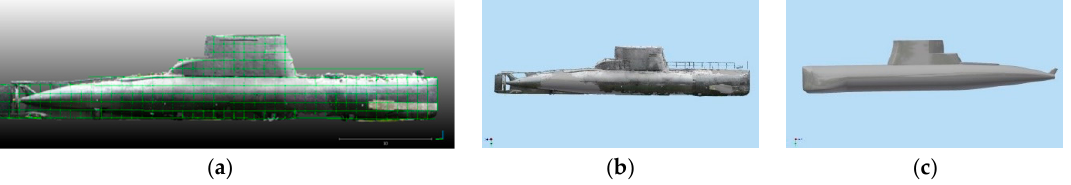
Figure 17. The hull cross sections (CAD line) ( a ), merged point cloud and 3D CAD modelled hull ( b ), 3D modelled hull ( c ).